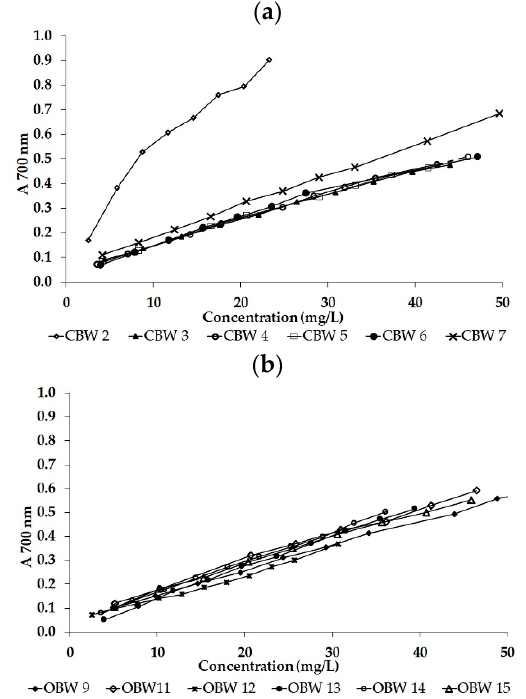
Figure 2. The reductive capacity of the tested conventional (CBW) ( a ) and organic (OBW) ( b ) group BW samples estimated by the RPA method (A 700nm—absorbance at 700 nm).